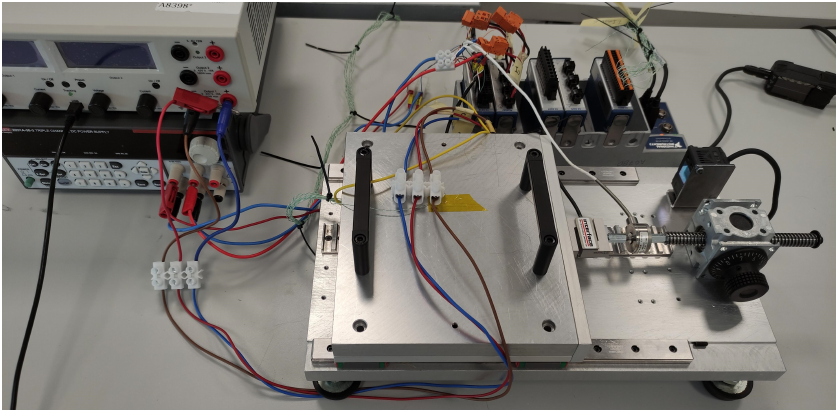
Figure 12. Thermal test setup of the LSFPM.